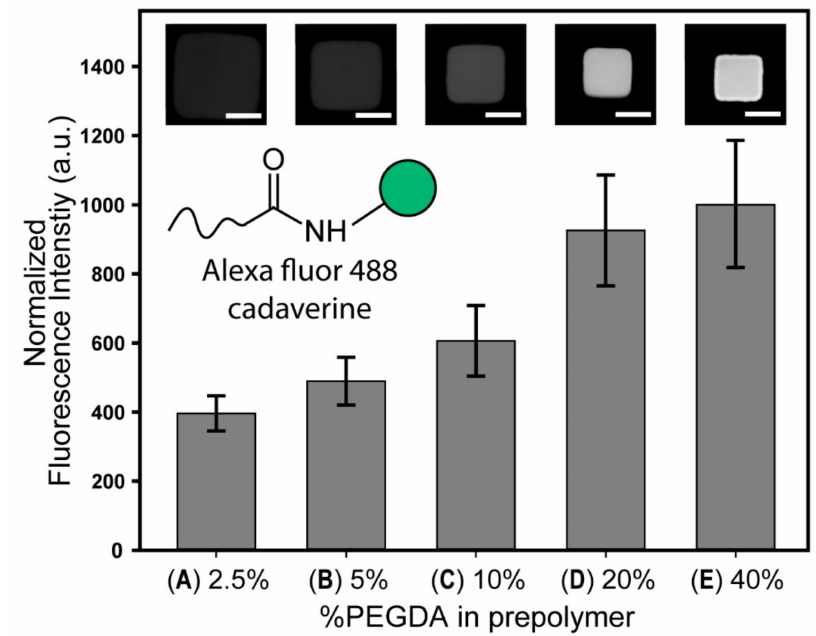
Figure 3. Characterization of fluorescence intensity obtained from carboxyl groups in the particles. Carboxyl groups are conjugated with Alexa fluor 488 cadaverine by carbodiimide chemistry. Fluorescence intensity is normalized on the basis of group E (40% PEGDA in prepolymer; Table 1). Each bar and error bar represent the average signal and standard deviation of 10–15 particles. Each image in the graph corresponds to the bar directly below. All the images are shown in same calibration profile of brightness and contrast. Scale bars are 50 µ